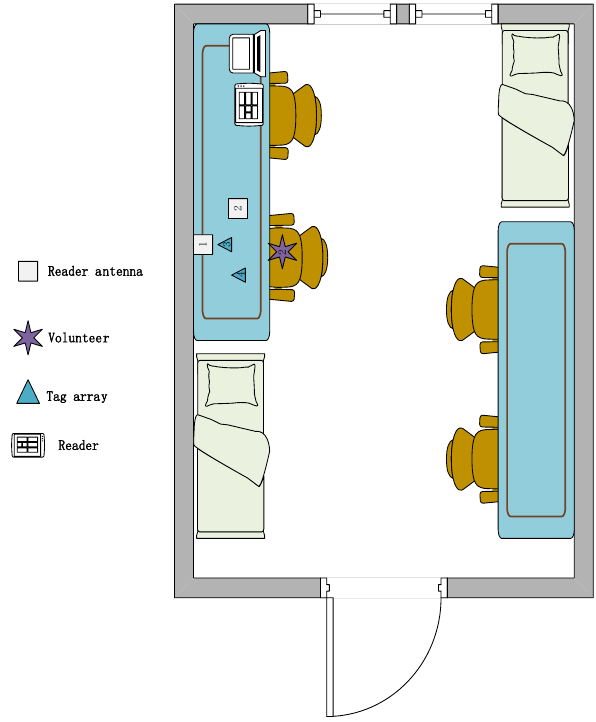
Figure 13. Dormitory experiment scene map.